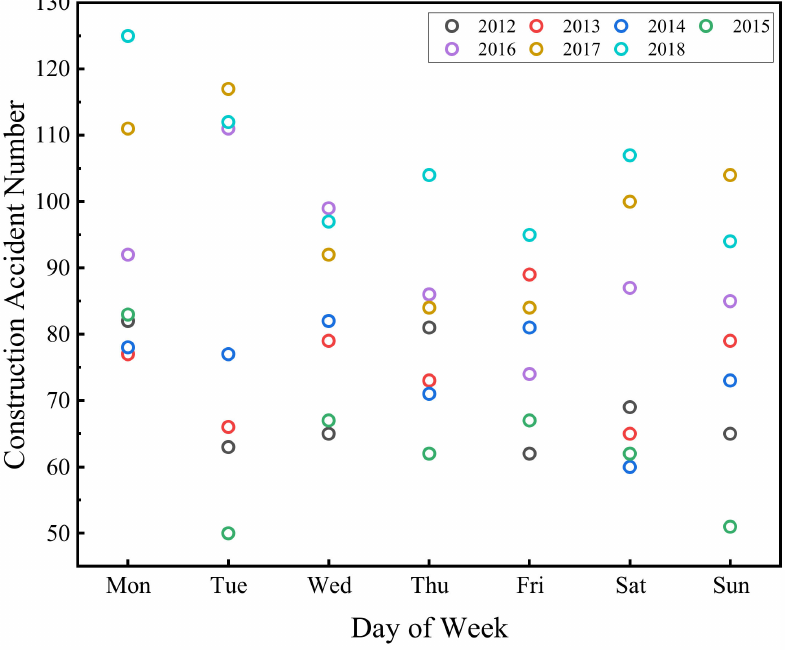
Figure 6. Scatter plot between day of week and construction accident